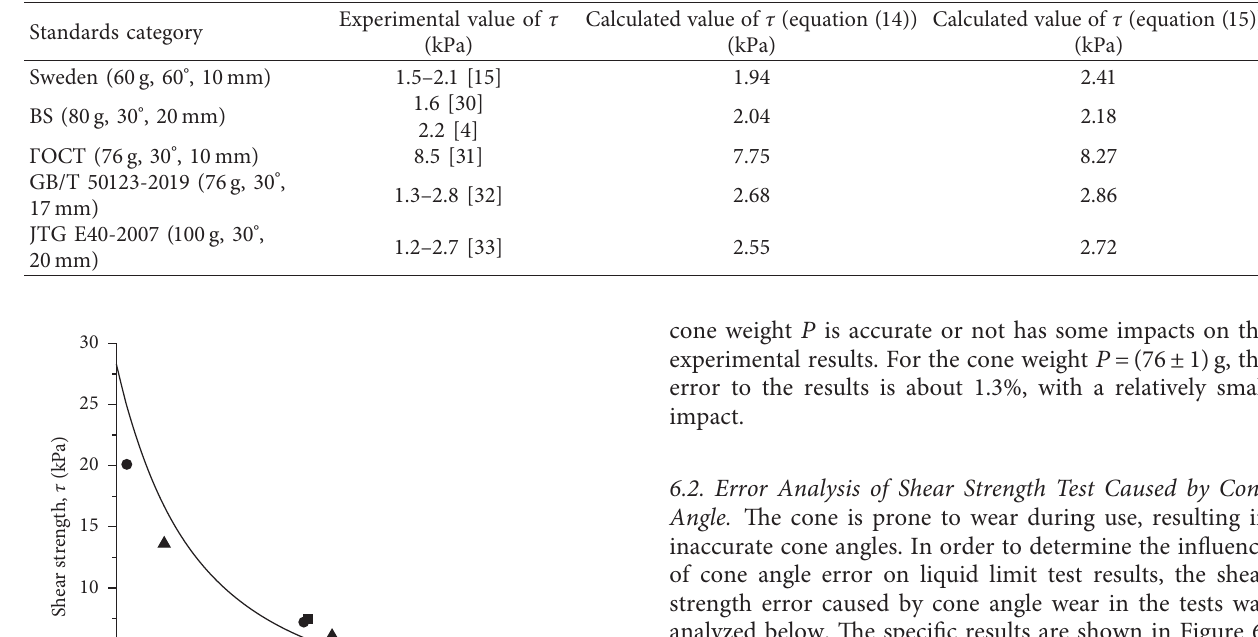
Table 2: Fall-cone instrument liquid limit strength.